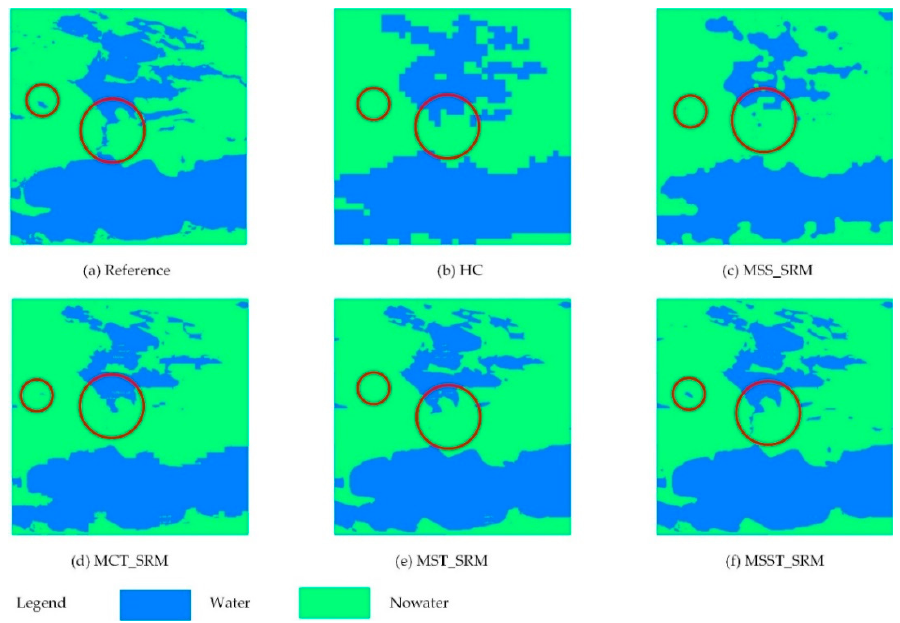
Figure 5. Resultant water body maps of the different methods for Tibet Plate Lake: ( a ) reference; ( b ) hard classification (HC); ( c ) MSS_SRM; ( d ) MST_SRM; ( e ) MSS_SRM; ( f ) multiscale spatiotemporal super-resolution mapping (MSST_SRM).